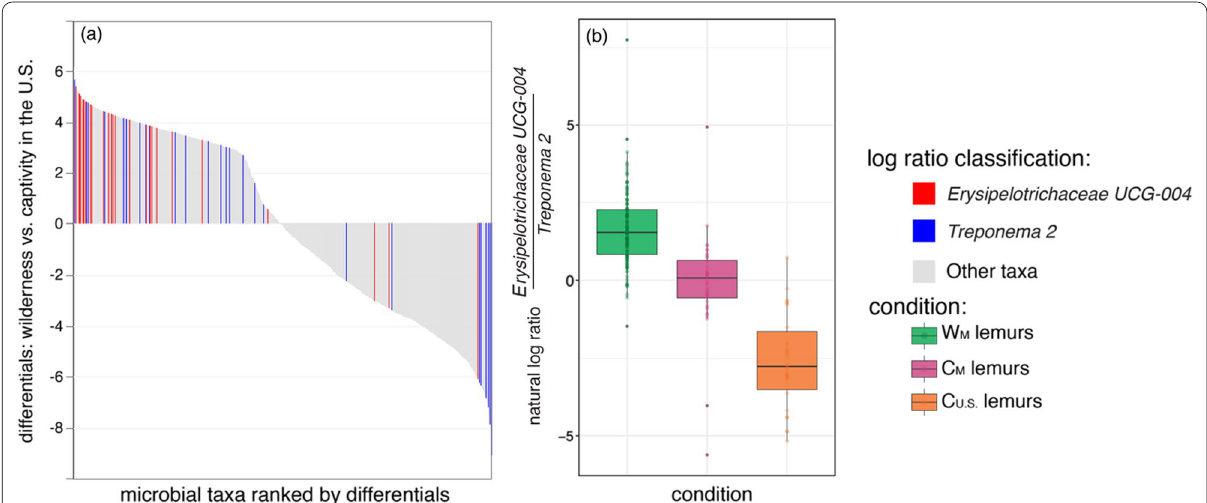
Fig. 3 Differential abundance of Erysipelotrichaceae UCG-004 and Treponema 2 amplicon sequence variants (ASVs) in the gut microbiota of lemurs. a Differential rank plot showing lemur gut microbial ASVs (x axis) ranked by their differentials (y axis; the estimated log-fold changes for taxa abundances across sample groups) for wild lemurs in Madagascar (W M ) vs. captive lemurs in the U.S. (C U.S. ). Those ASVs that are more abundant in W M lemurs compared to C U.S. lemurs appear on the right side of the plot whereas those that are less abundant in W M lemurs appear on the left side. The differentials of Erysipelotrichaceae UCG-004 and Treponema 2 ASVs are highlighted in red and blue, respectively, with other taxa represented in gray. b Natural log ratios of Erysipelotrichaceae UCG-004 versus Treponema 2 in lemurs across all three environmental conditions. Tukey-style box and whiskers show the median (center horizontal line) and the interquartile range (upper and lower bounds of the box), with outliers that are 1.5 times less than the 25th quartile or 1.5 times more than the 75th quartile. Each point represents a single lemur gut microbiome in which the target ASVs were